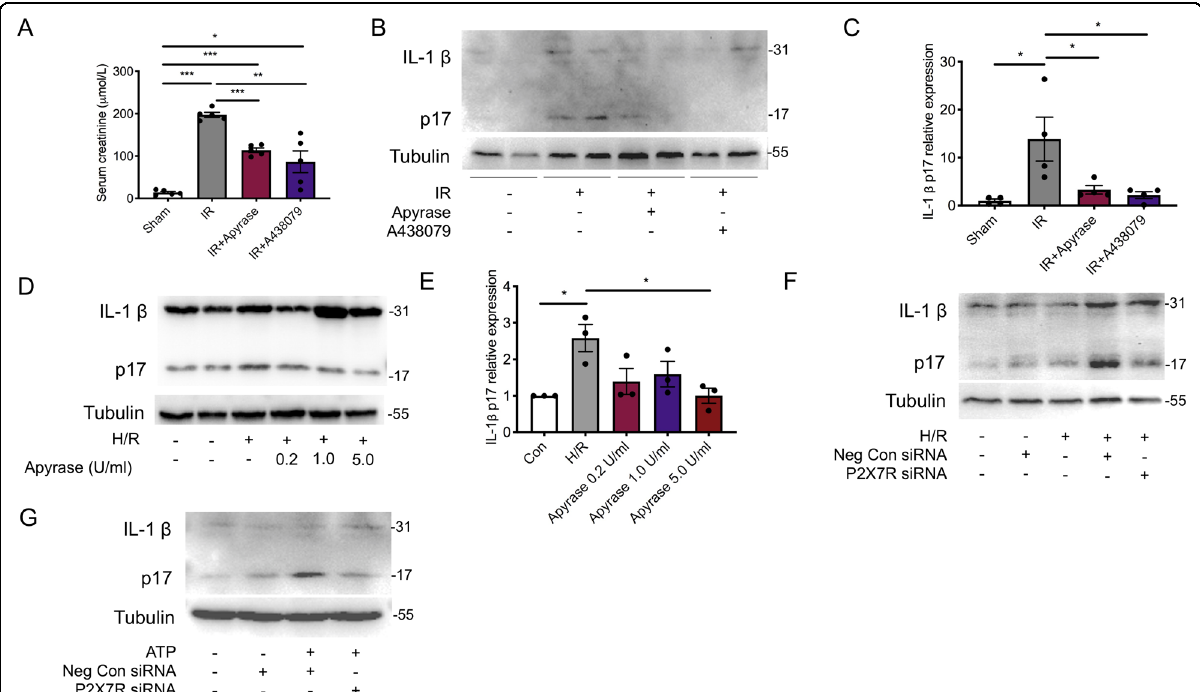
Fig. 2 Extracellular ATP/P2X7 receptor contributed to the upregulation of active IL-1 β expression in response to renal ischemia- reperfusion injury. A total of twenty wild-type mice were randomly divided into the Sham, Ischemia-Reperfusion, Ischemia-Reperfusion + Apyrase, and Ischemia-Reperfusion + A438079 groups, and were intravenously applied with phosphate-buffered saline, Apyrase, or A438079 at 30 min post- reperfusion accordingly. A The concentrations of serum creatinine were measured. B Representative immunoblots and C aggregate densitometric quanti fi cation of whole-kidney lysate for IL-1 β p17 expression. HK2 cells were subjected to D – F hypoxia for 24 h followed by reoxygenation for 8 h or to G ATP at 4 mM, with or without indicated pretreatment. D , F , G Representative immunoblots and E aggregate densitometric quanti fi cation of cell lysate for IL-1 β p17 expression. * p < 0.05, ** p < 0.01, *** p <